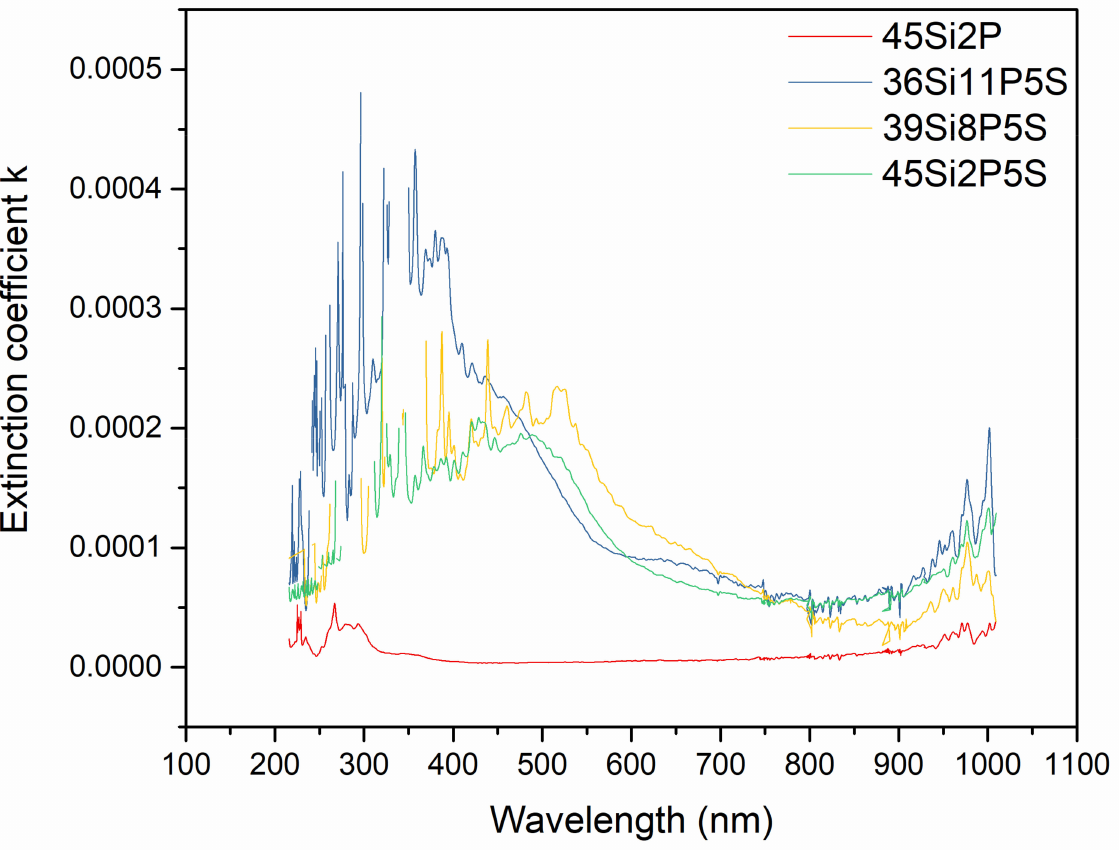
Figure 12. Extinction coefficient vs. wavelength for the silicate–phosphate glass samples: 36Si11P5S, 39Si8P5S, 45Si2P5S, and